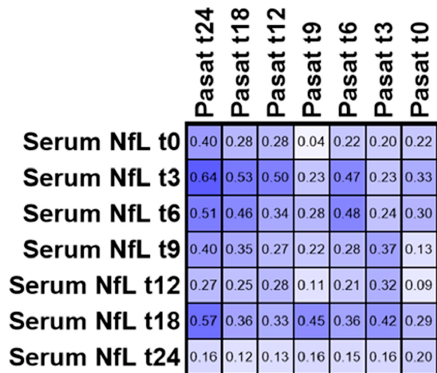
Figure 4. Correlation matrix of Spearman correlation analysis for serum NfL and PASAT. Numbers in the cells are showing the respective Spearman correlation coefficient.